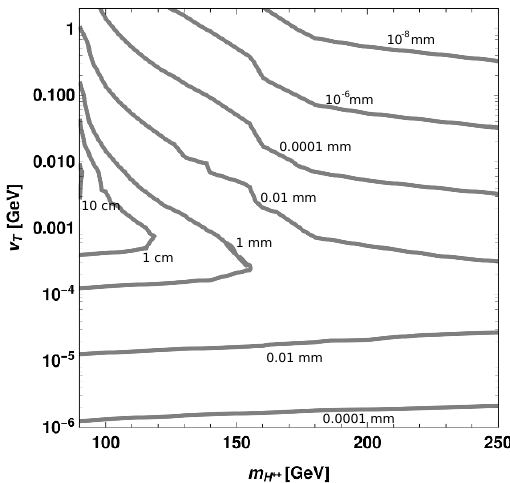
Figure 4 . Contours of proper decay length c(cid:28) , where (cid:28) is the proper lifetime, of the doubly charged scalar particle H (cid:6)(cid:6) as a function of its mass and the triplet VEV v T .